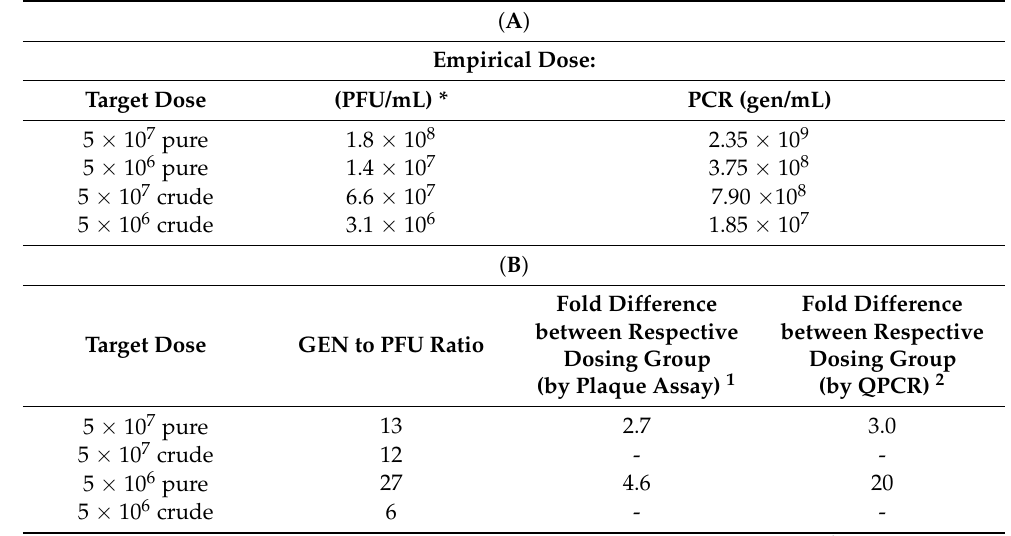
Table 1. Comparison of purified and unpurified monkeypox virus inoculums.